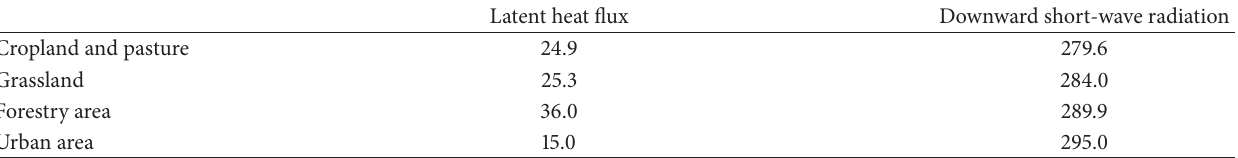
Table 2: Statistics of heat flux and radiation of different land covers (unit: W/m 2